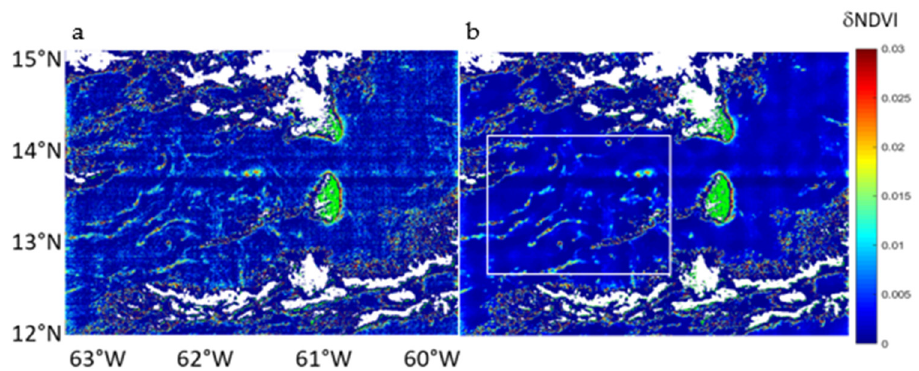
Figure 6. ( a ) NDVI deviation ( δ NDVI) calculated from GOES hourly data on 8 August 2018 at 16:30 UTC (left panel) and ( b ) application of the non-local means filtering technique (right panel). The white box indicates the location of the study area.